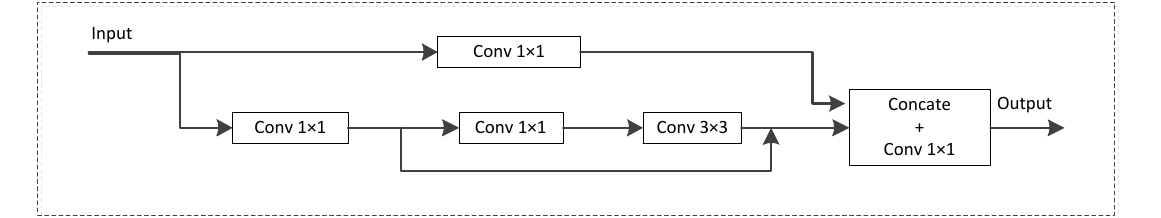
Figure 2. CSPNet module. Conv 1 × 1 denotes general convolution operations with kernel = 1. Conv 3 × 3 denotes general convolution operations with kernel = 3. Concate denotes the characteristic concatenation operation.